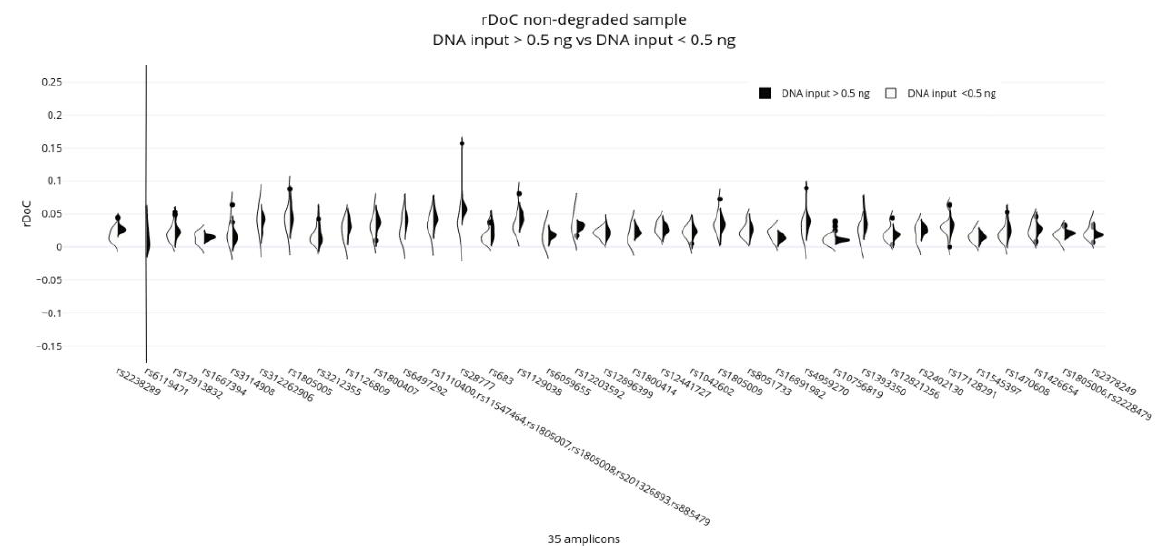
Figure 1. Comparison of rDoC distribution observed in non-degraded samples pooled in two groups according to the DNA input used for amplification, named as follows: DNA input > 0.5 ng and DNA input < 0.5 ng. X -axis: polymorphisms included in the amplicons; Y -axis: value relative depth of coverage (rDoC).